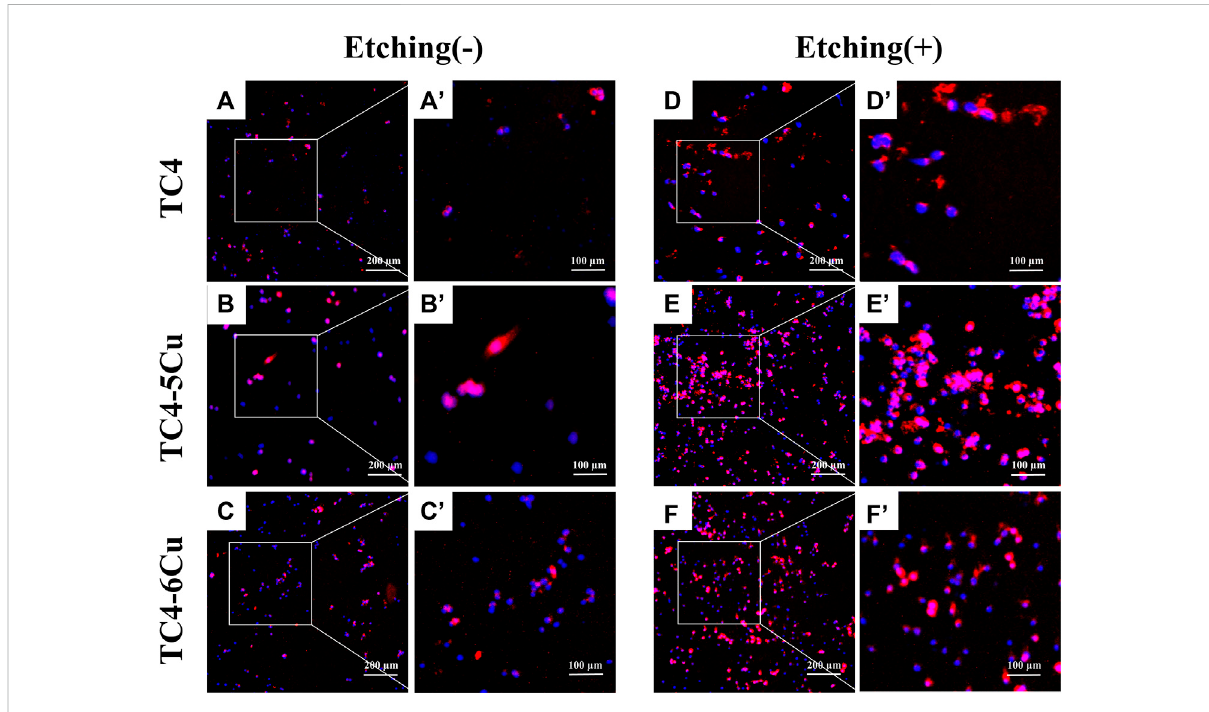
FIGURE 5 CelladhesionofRAW 264.7 cellscultured on thesurfaceofdifferentalloys for 24 h. (a ’– f ’ ) isapartial enlargement oftheselectedareaof (A – F) .